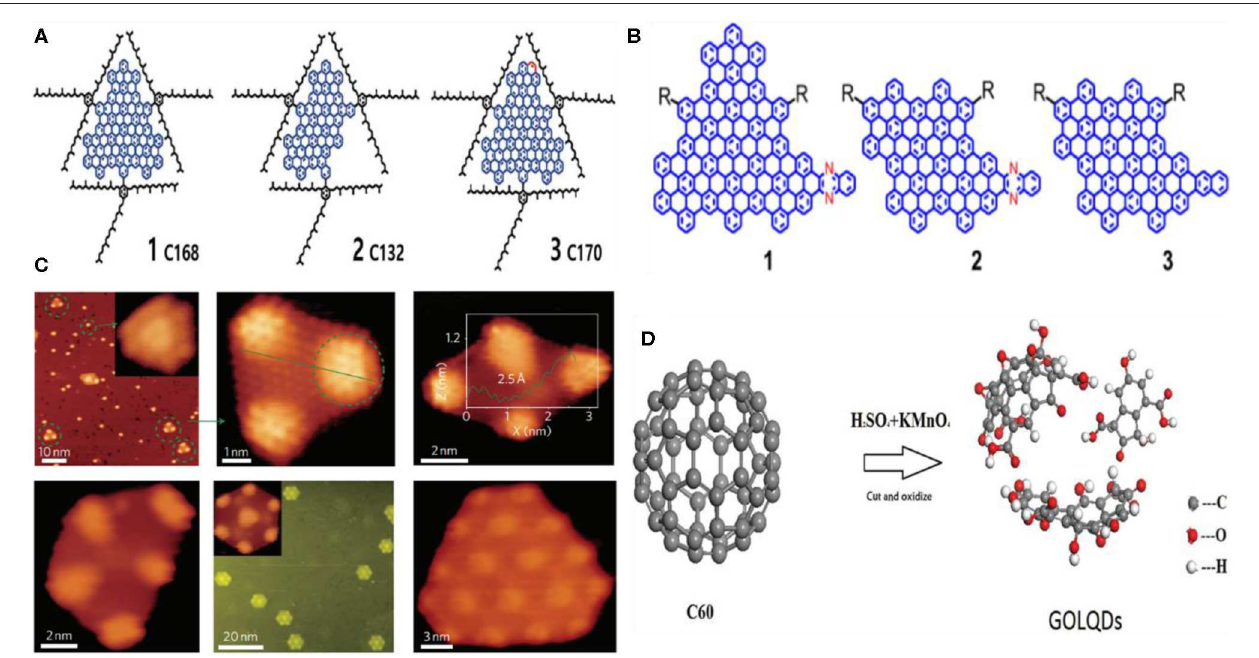
FIGURE 7 | (A) GQDs containing different (170, 132, and 168) conjugated carbon atoms; reproduced from Yan et al. (2010) with permission from the American Chemical Society. (B) The representation of three different colloidal GQDs prepared by solution chemistry; reproduced from Li et al. (2012b) with permission from the American Chemical Society. (C) STM images represented the different shapes of GQDs prepared by cage opening approach; reproduced from Lu et al. (2011) with permission from Nature Publishing Group. (D) Illustration of the process of graphene-oxide-like QDs (GOLQDs) formation by the oxidization of C 60 ; reproduced from Chen et al. (2015) with permission from